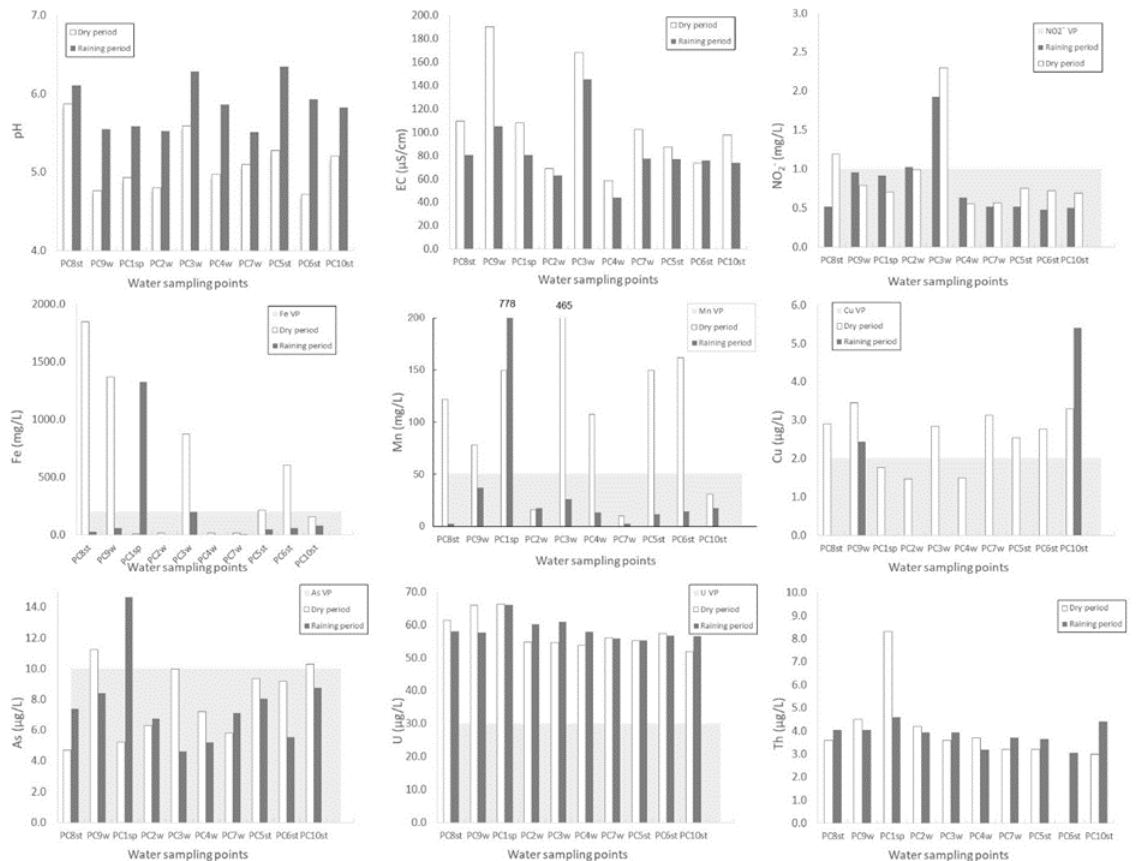
Figure 6. Diagrams of seasonal variation for the waters of the Picoto area. Water sampling points: st — stream; w — well; sp — spring; VP — parametric value [43 – 45].